Question: What direction does the quantity move in — increasing or decreasing?
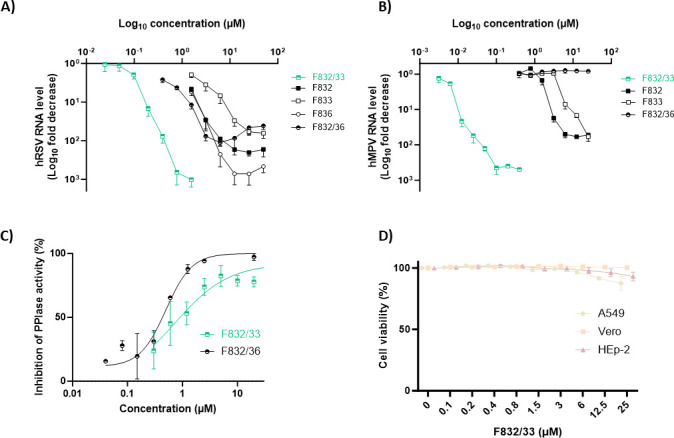
Answer: increasing